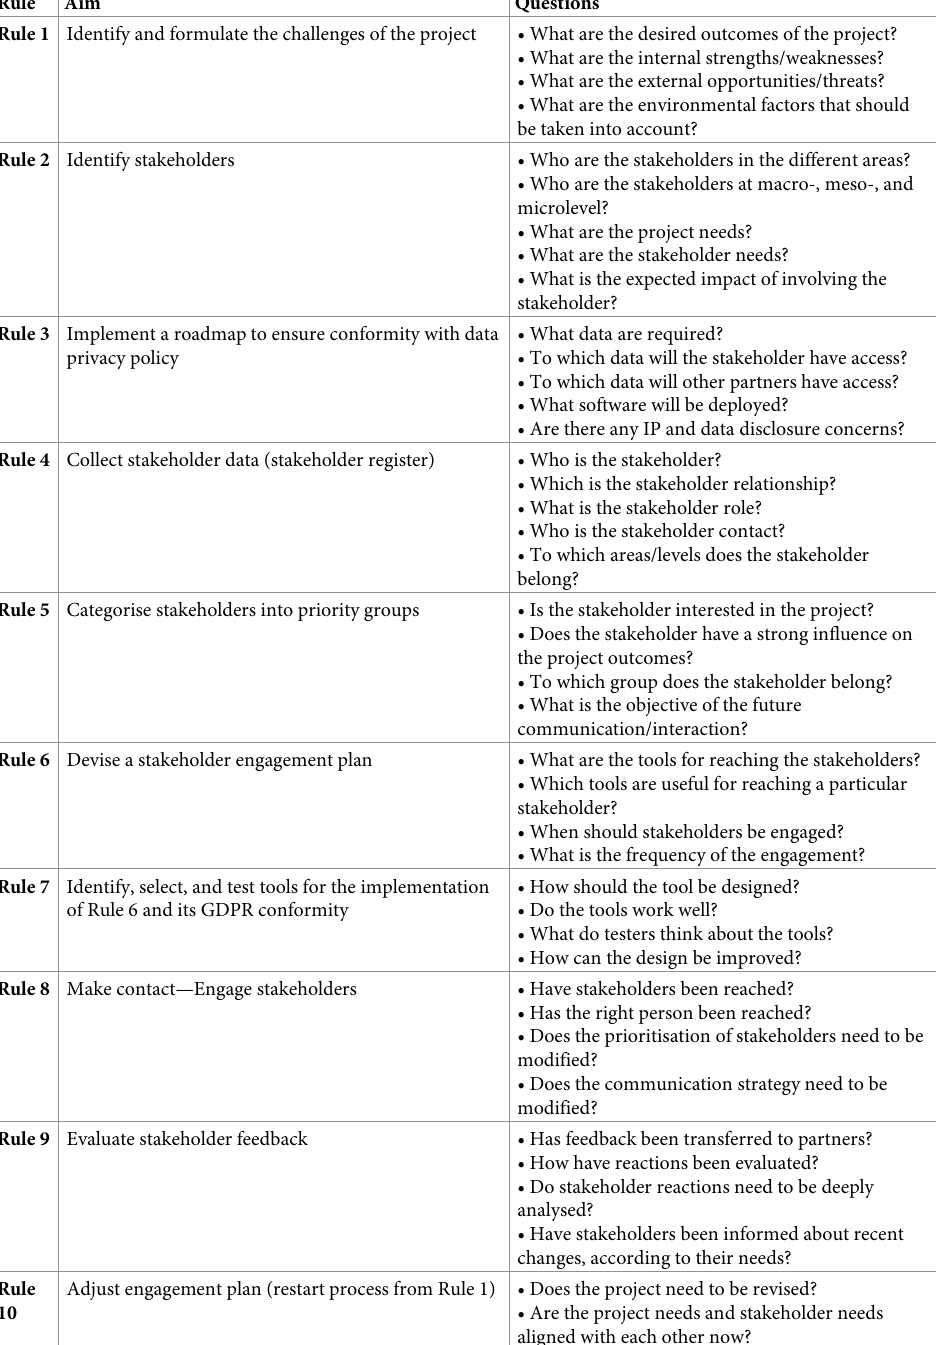
Table 4. Nonexhaustive list of questions for developing a stakeholder engagement